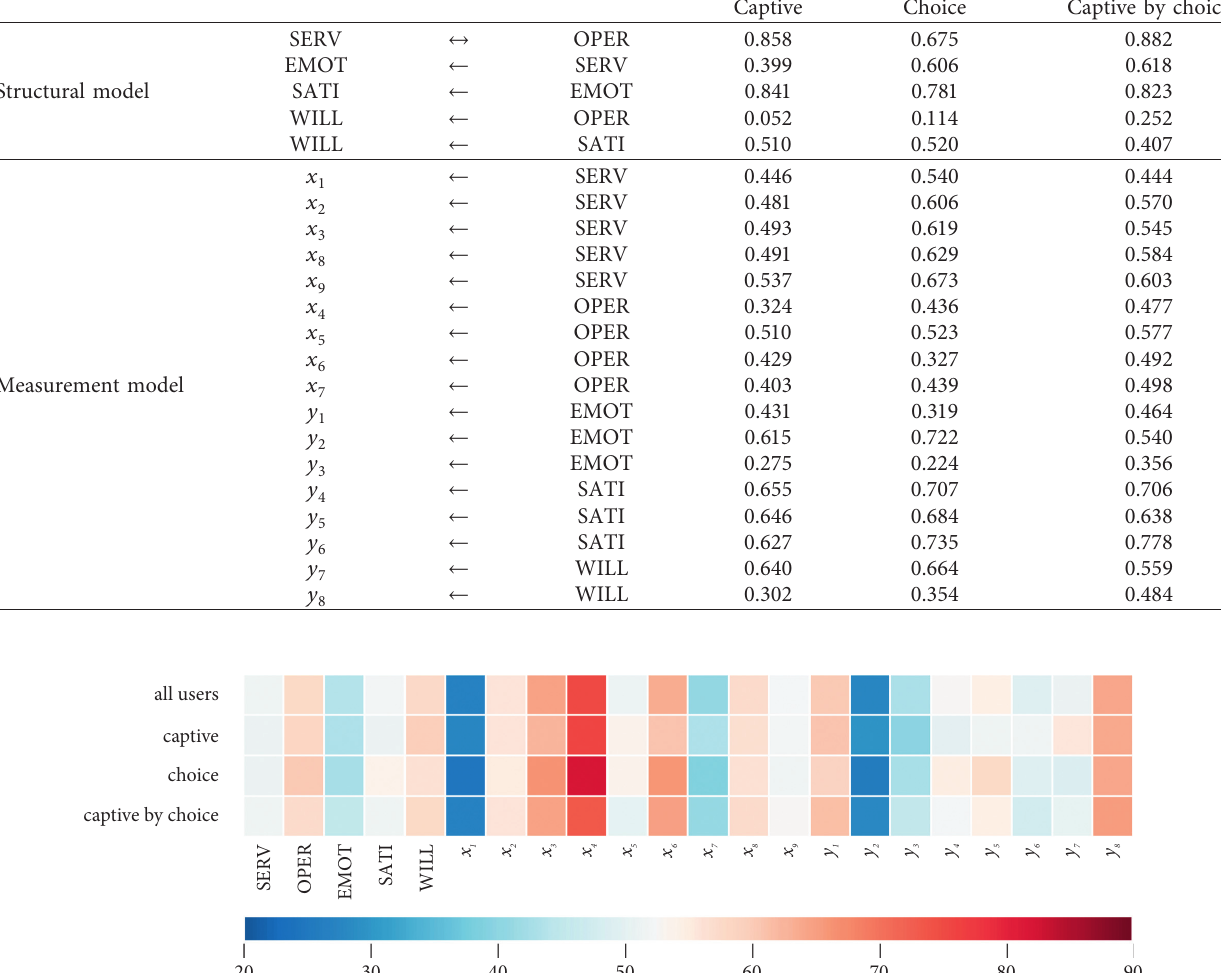
Table 9: Comparing results for different groups.